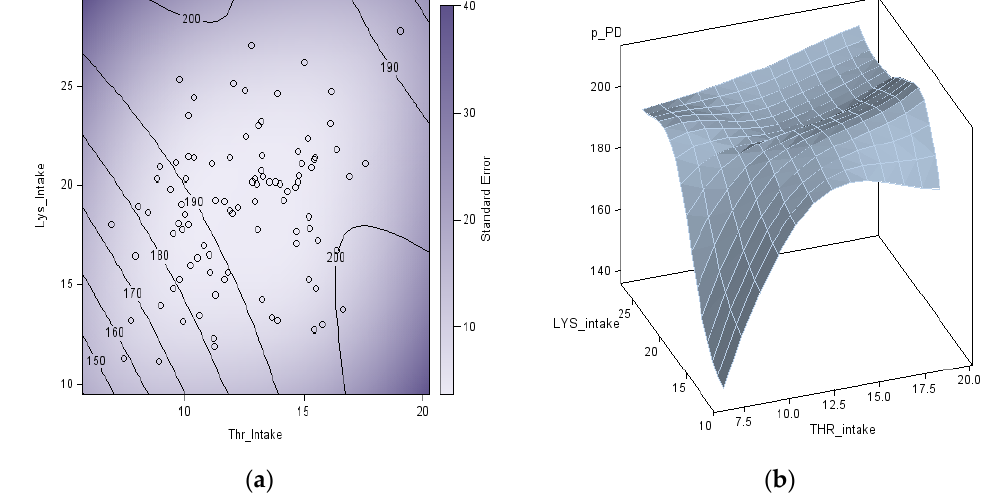
Figure 2. Response contour graphic of the canonical analysis ( a ) of protein deposition (PD; g/day) as a function of lysine intake (g/day) and threonine (g/day) intake, and as three-dimensional response surface ( b ) based on a nonparametric locally polynomial regression method (LOESS function) on a central composite design .